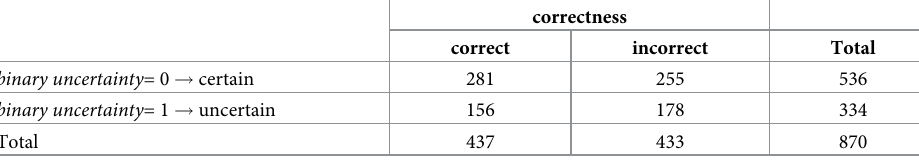
Table 4. Correctness vs Stated_U, here aggregated into binary uncertainty